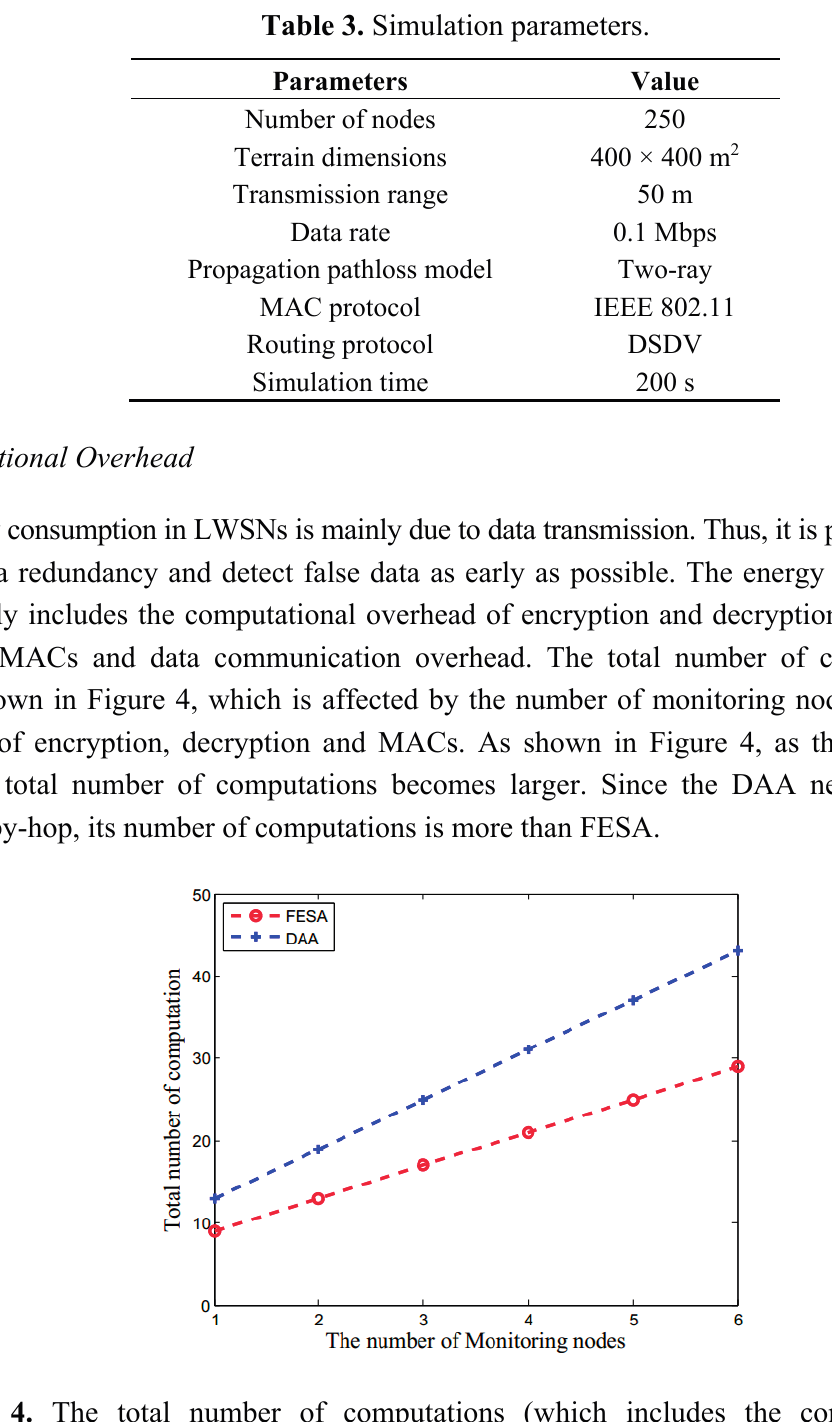
Figure 4. The total number of computations (which includes the computations of encryption, decryption and MACs) versus the number of network monitoring nodes for FESA and